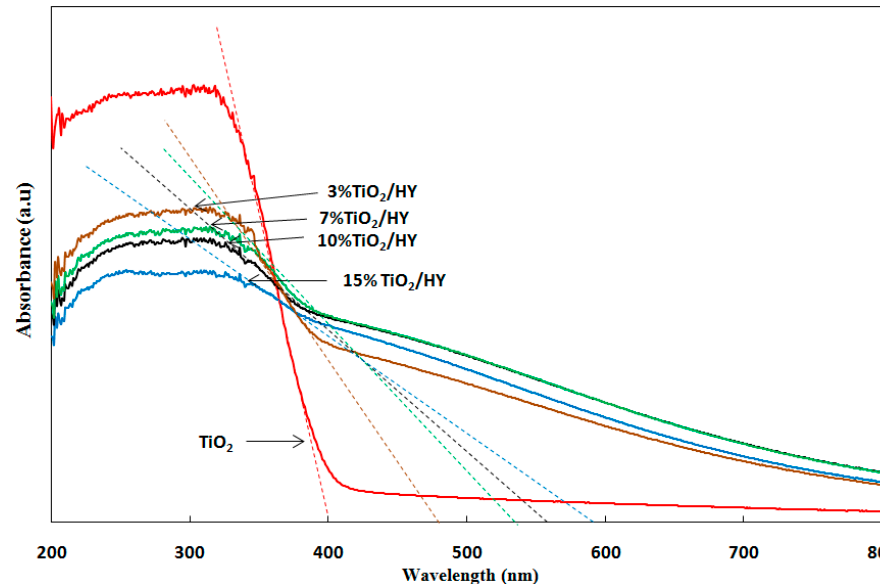
Figure 5. UV ‐ VIS spectra of HY, TiO 2 , and the series of 3, 7, 10, and 15 wt% TiO 2 /HY systems. Figure 5. UV-VIS spectra of HY, TiO 2 , and the series of 3, 7, 10, and 15 wt% TiO 2 /HY